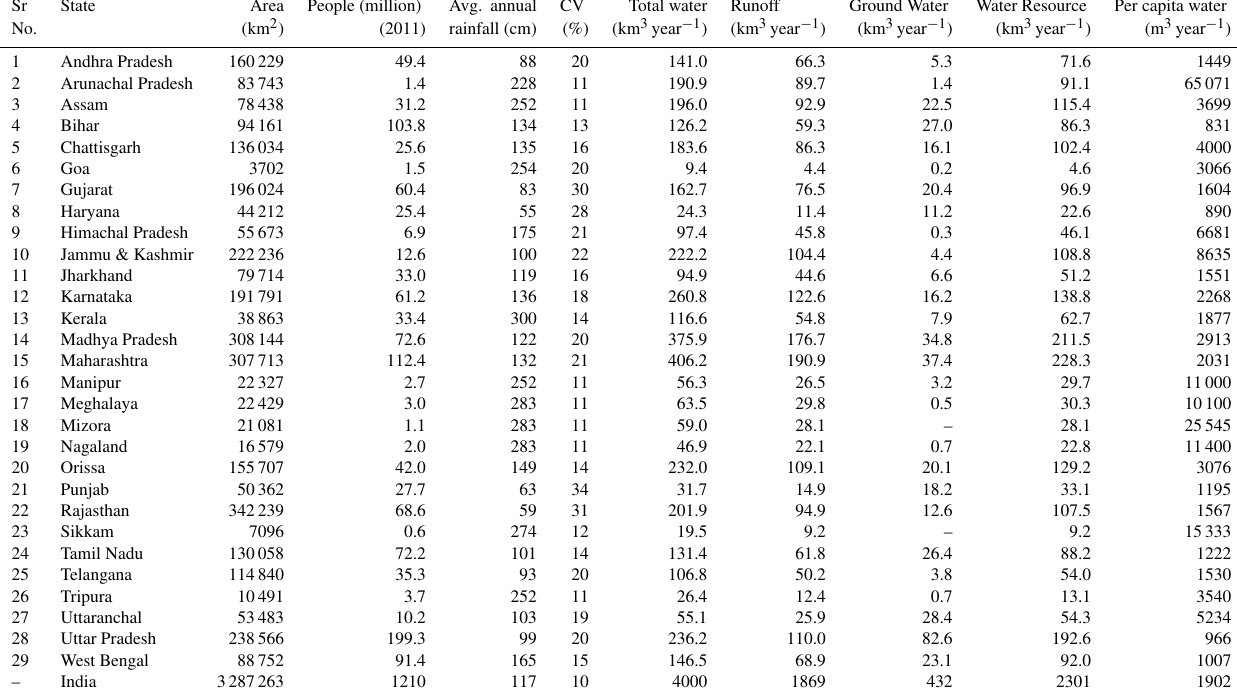
Table 3. Land, Population and Water Resources of 29 states in India (Source: IMD, 1962 and M.I&B, 2012). Sr